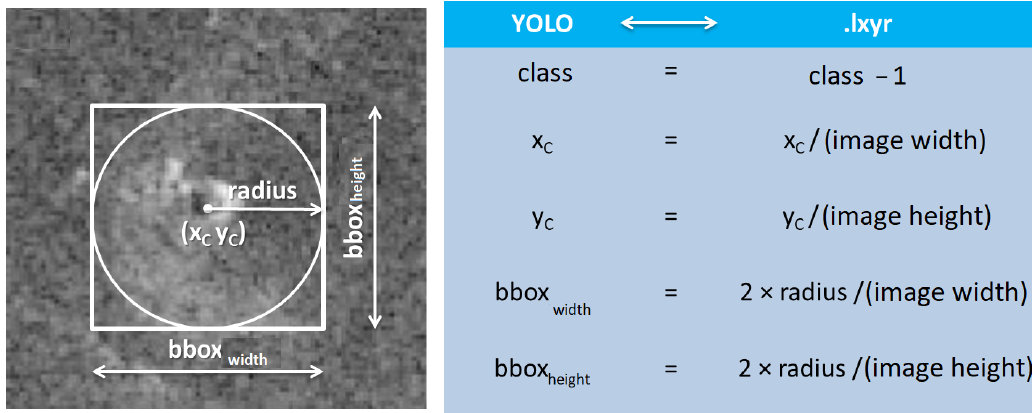
Figure 6. The method of transferring labels from Magellan format to YOLO